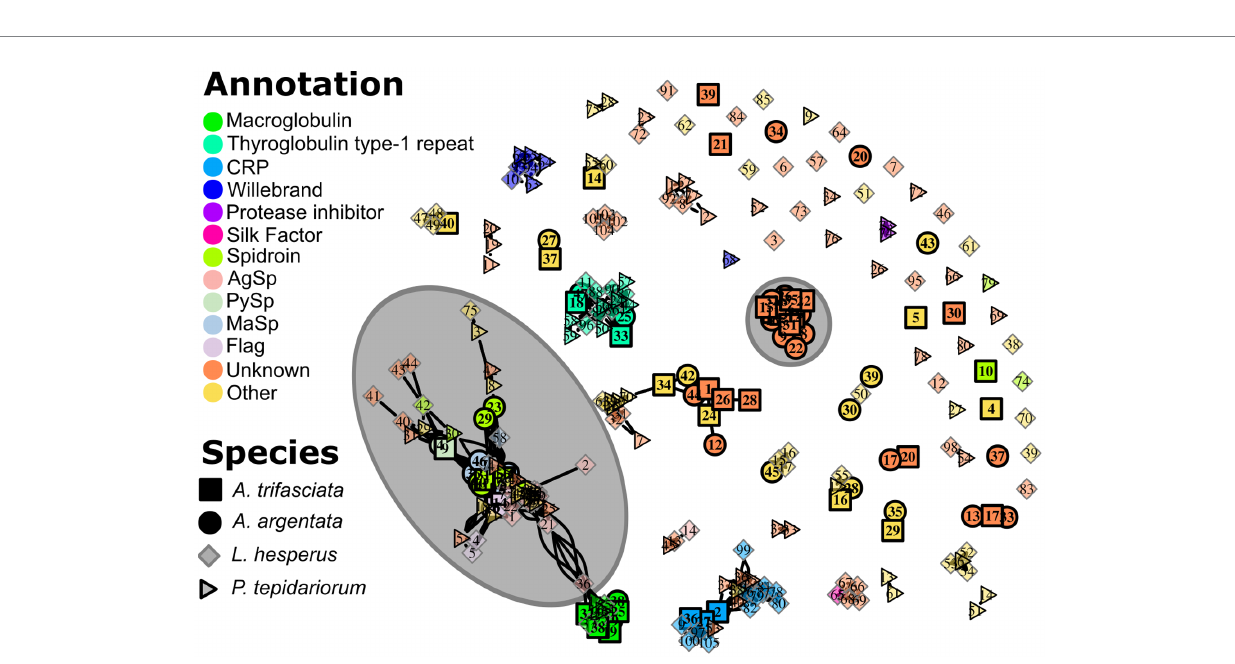
FIGURE 6 The relationships among capture spiral ( A. argentata and A. trifasciata ) and gumfoot proteins ( Latrodectus hesperus and Parasteatoda tepidariorum , Ayoub et al., 2021) shown as a network graph. A connecting line indicates a significant BLASTP alignment. Interior color indicates the predicted protein annotation and the number is a species-specific protein identifier (see Supplementary Tables S1, S2, and Ayoub et al., 2021). The large grey circle encompasses all the predicted spidroins. Also encircled is a large cluster of Argiope proteins with no gumfoot homolog and no prior annotation (“Unknown”) that are highly abundant in the capture spirals (Figure 7) and have many conserved Cysteine residues (Supplementary Figure